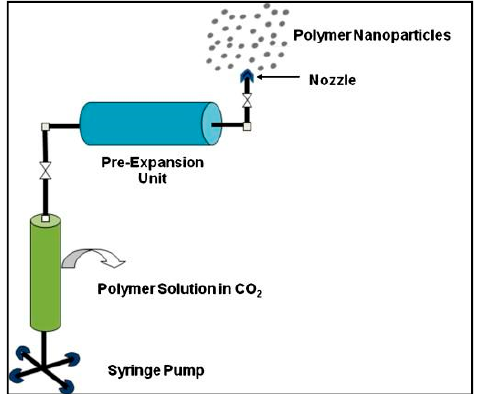
Figure 7. Experimental set-up for preparation of polymer nanoparticles via the rapid expansion of supercritical fluid solution. Reprinted with permission from Reference [73]. Copyright 2011 Elsevier.